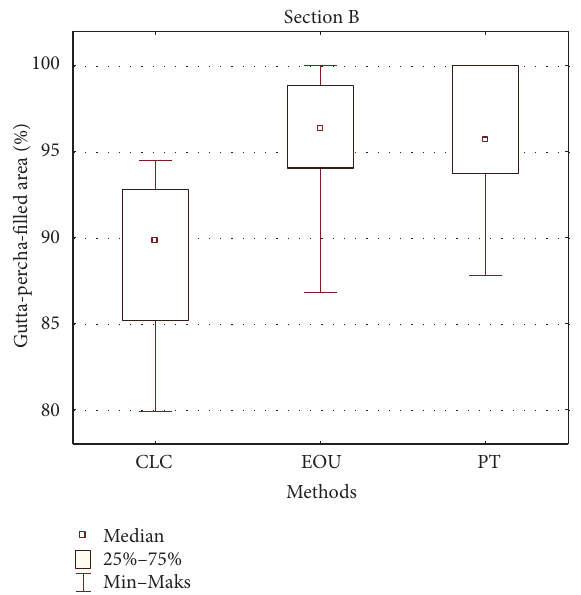
Figure 8: Box plots illustrating the median traces and minimal and maximal values of the gutta-percha-filled area in each experimental group, section